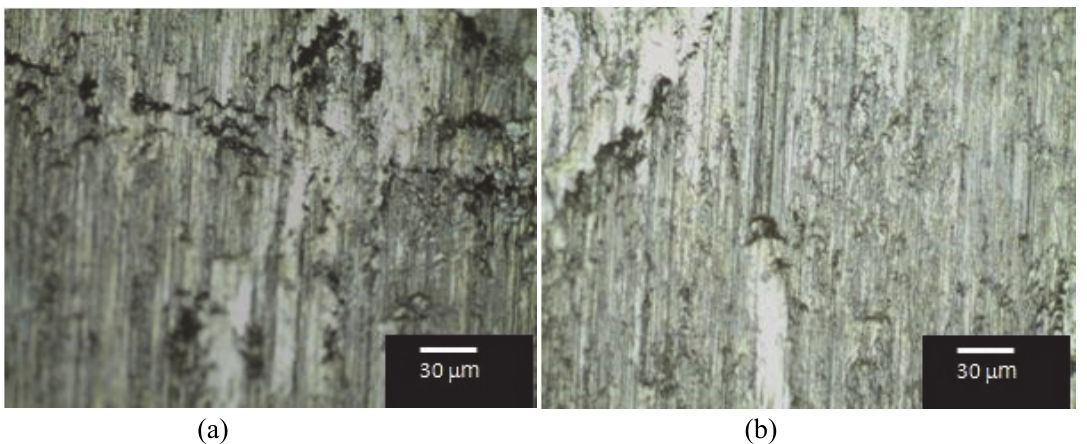
Fig. 9. Optical micrographs of machined surface after turning at V=206 m/min, f= 0.2 mm/rev, d=